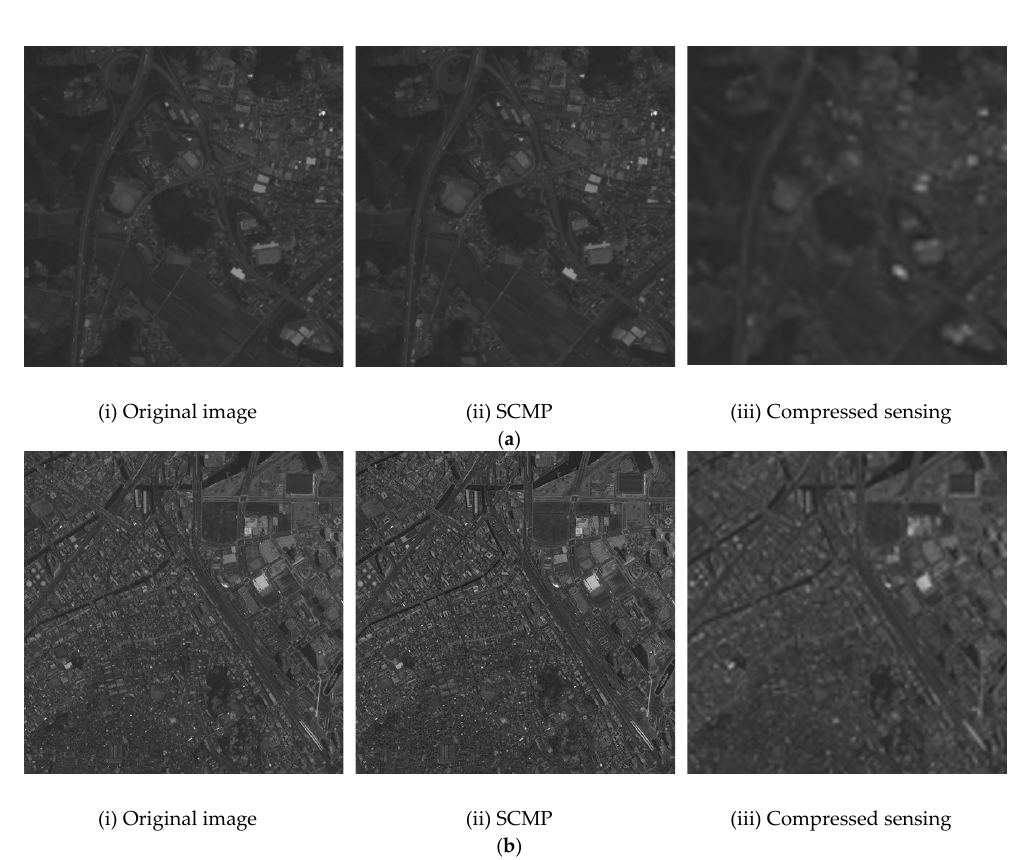
Figure 2. Intensity of RGB images of ( a ) Nihonmatsu, ( b ) Yokohama. (i) Intensity of the original image, (ii) intensity of SCMP, (iii) intensity obtained via compressed sensing.